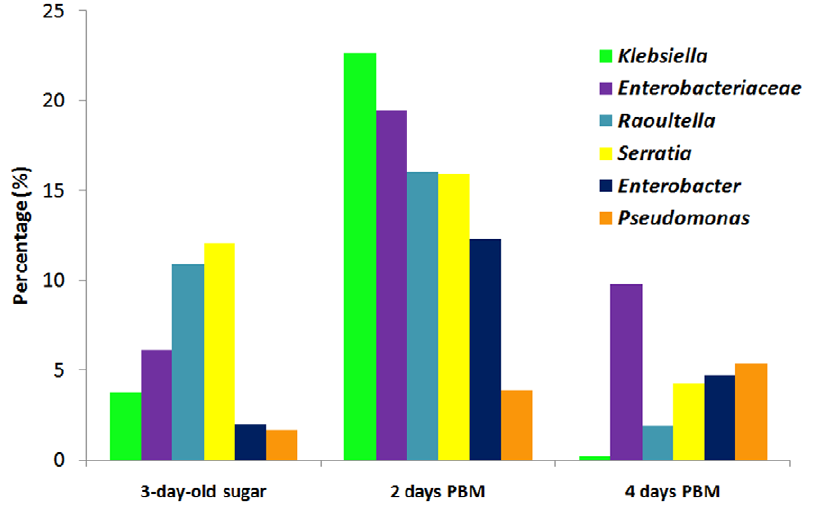
Figure 4. Abundant genera in the gut community after blood feeding. Unclassified Enterobacteriaceae represents the reads that were assigned to the family Enterobacteraceae , but were not able to be assigned to a genus.